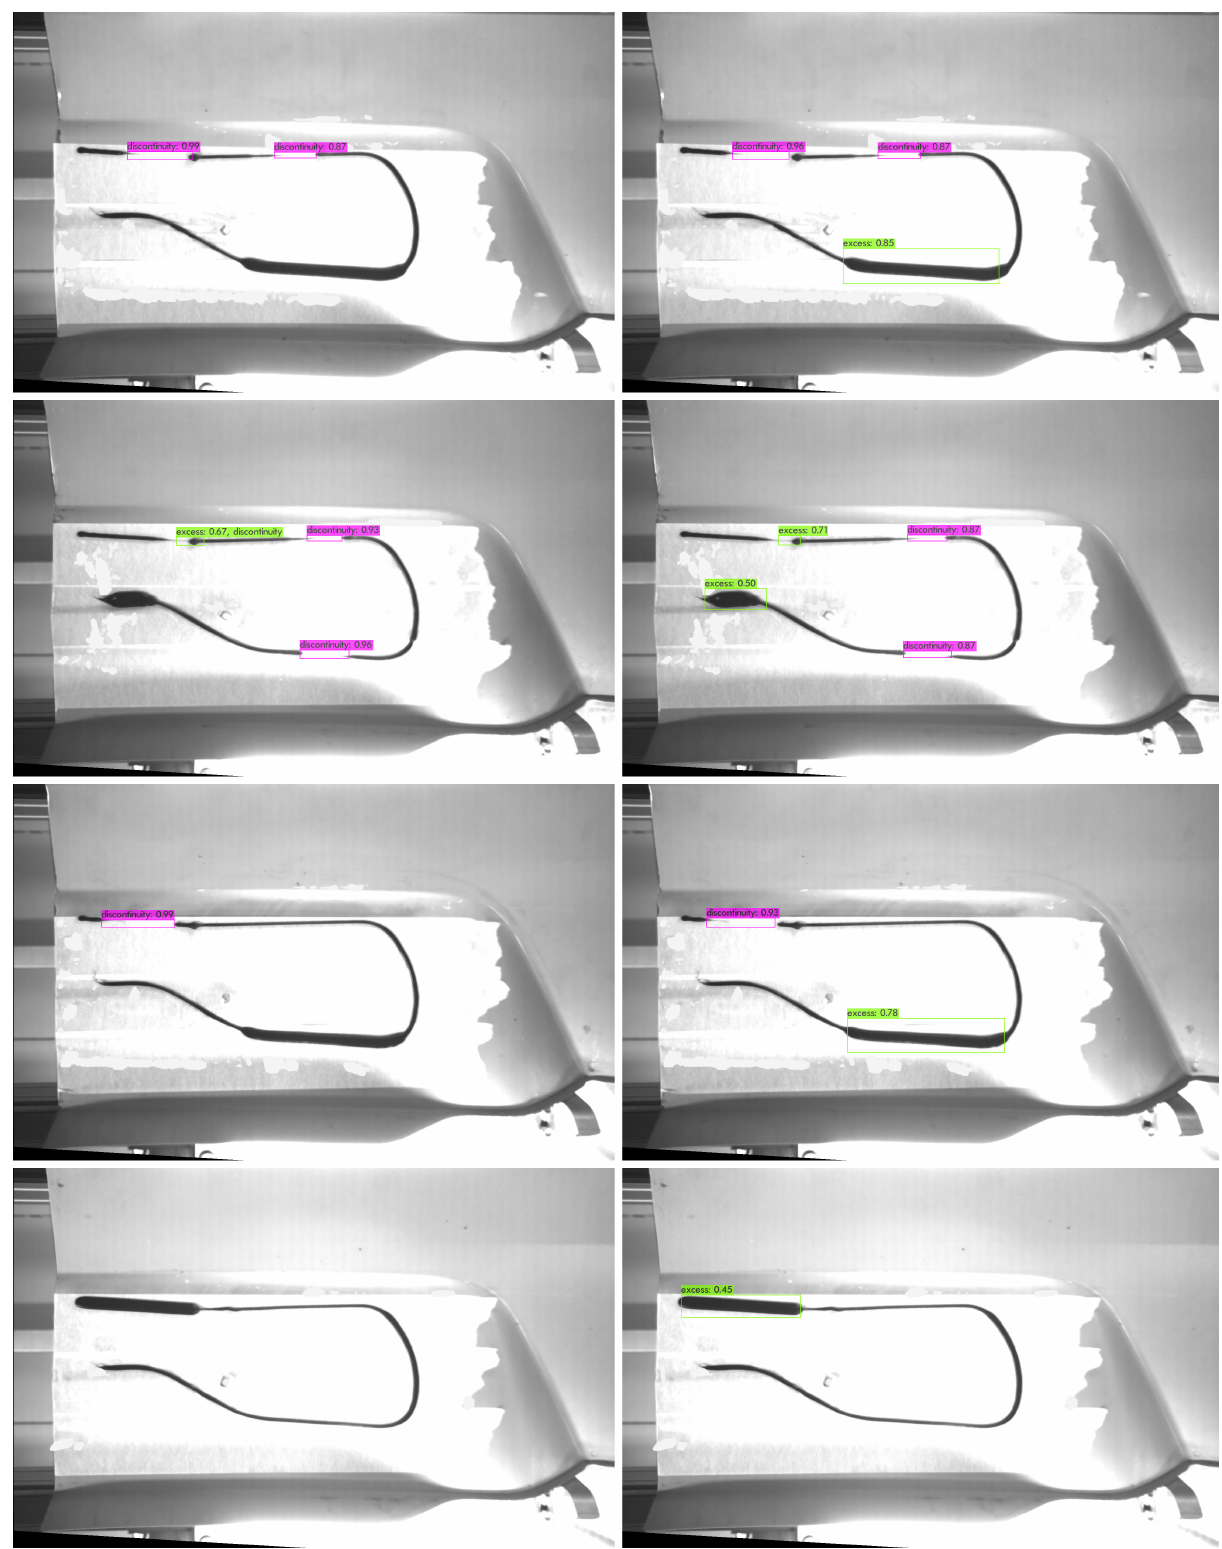
Figure 4. Examples from the output of the YOLOv4-Tiny models running inference on the holdout set. Left column depicts the output from the model trained only on real data, while the right column represents the corresponding result from the model trained on the augmented